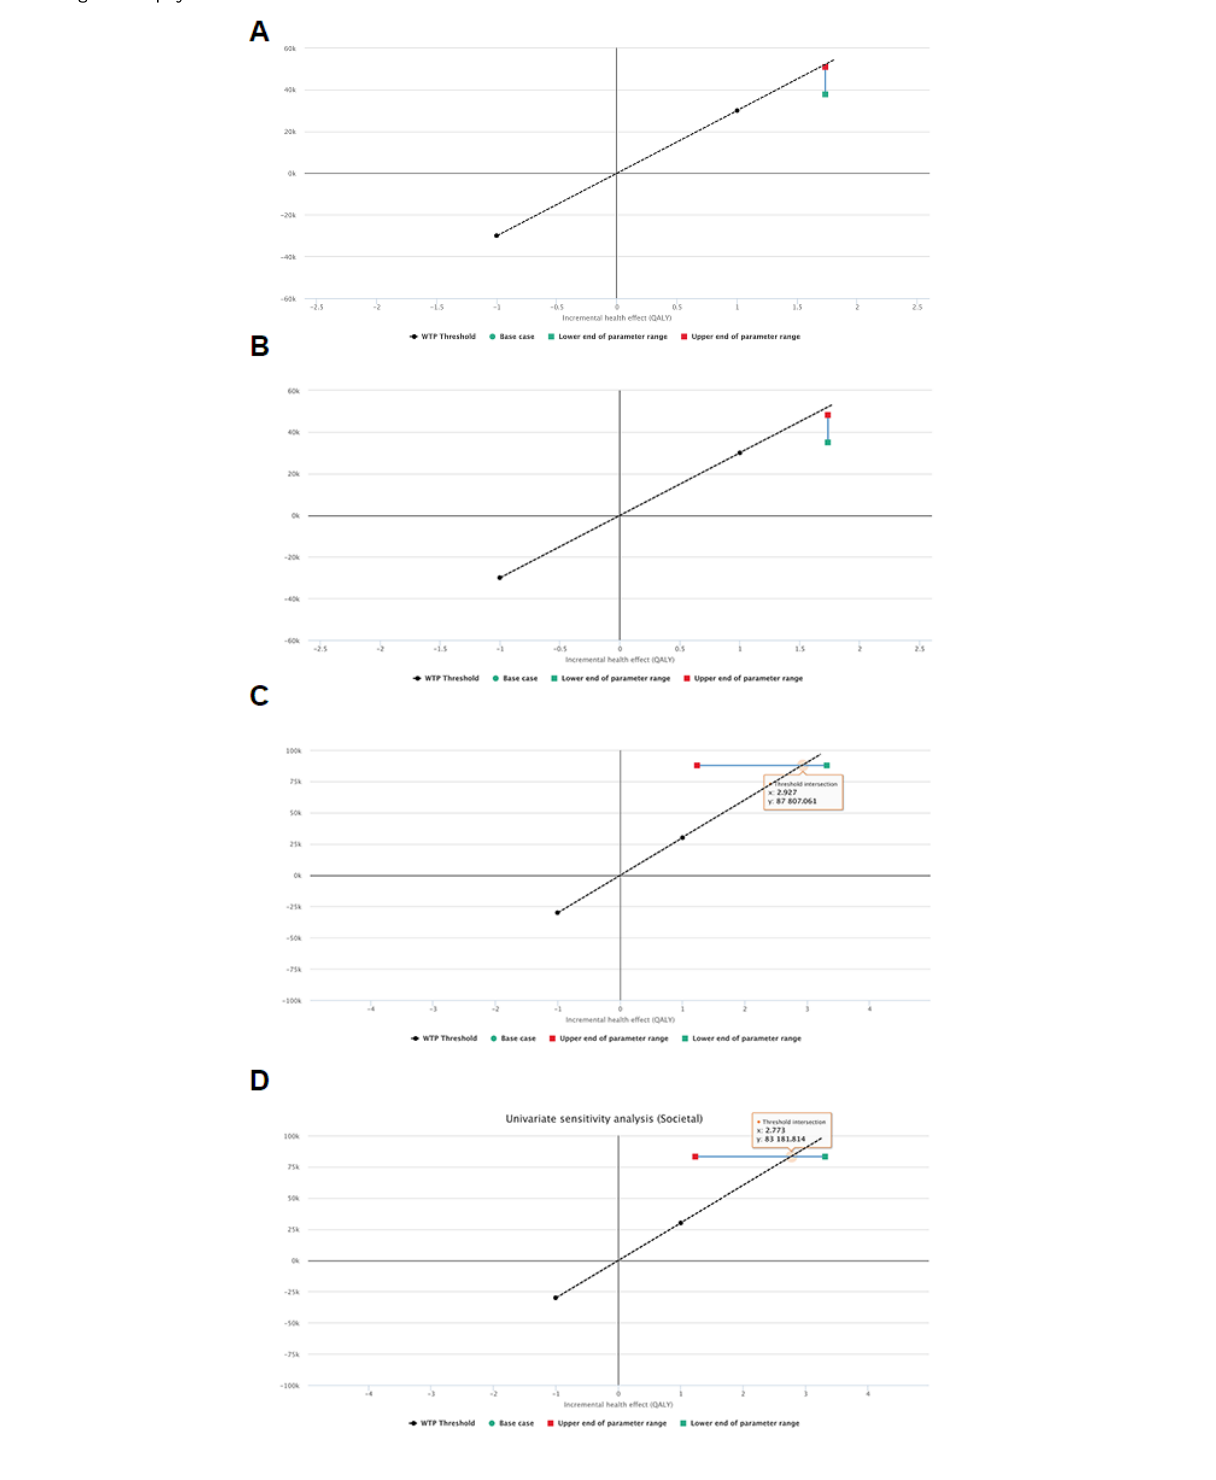
Figure 3. Cost-effectiveness planes of sensitivity analyses. A reduction of up to 25% in cost per session (A and B for healthcare and societal perspectives, respectively), and 0% to 5% discount in effects (C and D for healthcare and societal perspectives, respectively). The dotted black line shows the 30,000 €/QAL Y willingness-to-pay threshold (equivalent to approximately US $36,060; an exchange rate of approximately €1 to US $1.20 is applicable at the time of publication). The solid green line shows the range of the incremental cost-effectiveness ratio, with the red and green squares indicating the range extremes for the worse (more costly or less effective) and best (less costly or more effective) scenario, respectively. QALY: quality-adjusted life-year. WTP: